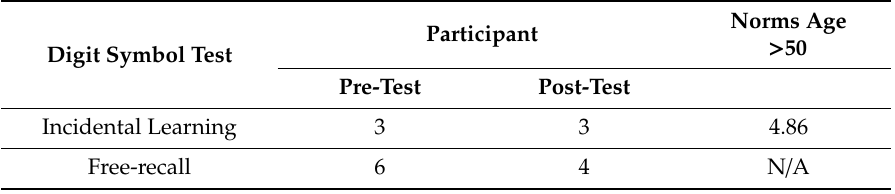
Table 2. Results of Digit Symbol Test and Comparison to Normative Data